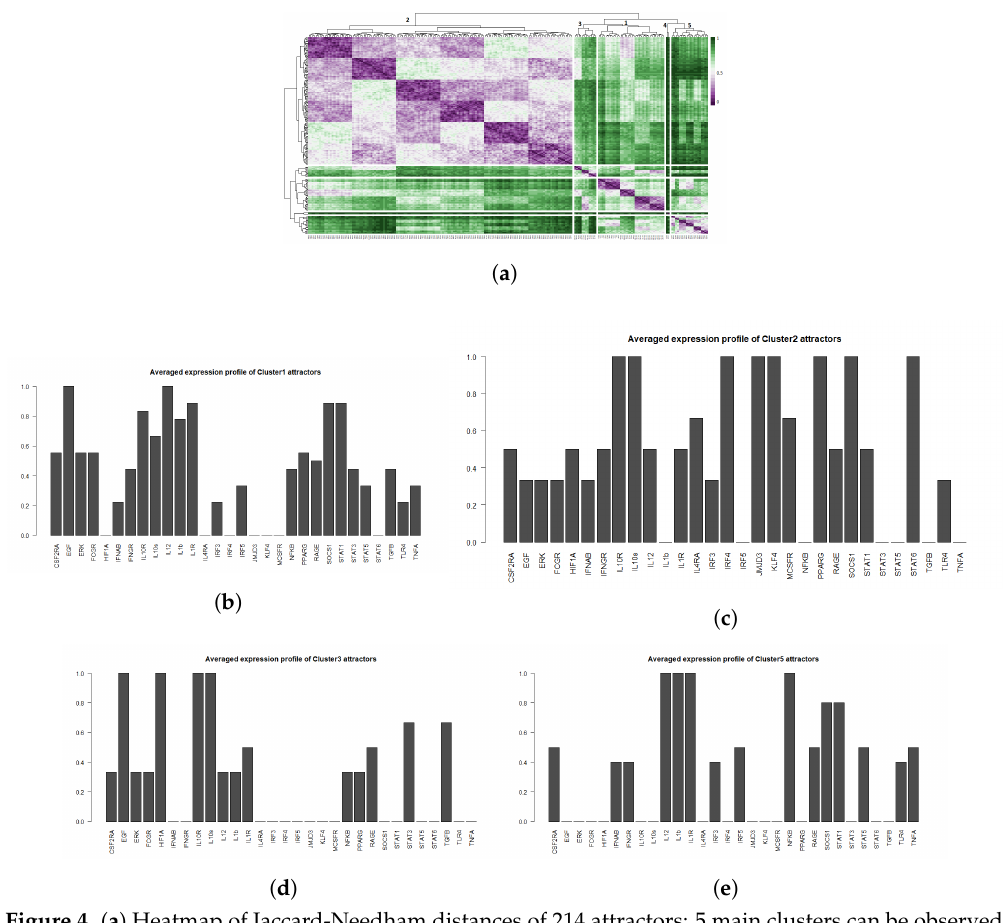
Figure 4. ( a ) Heatmap of Jaccard-Needham distances of 214 attractors: 5 main clusters can be observed. Cluster 4 contains the attractor with all nodes in the OFF state and was not considered for further analysis. ( b – e ) Averaged attractors for each cluster in ( a